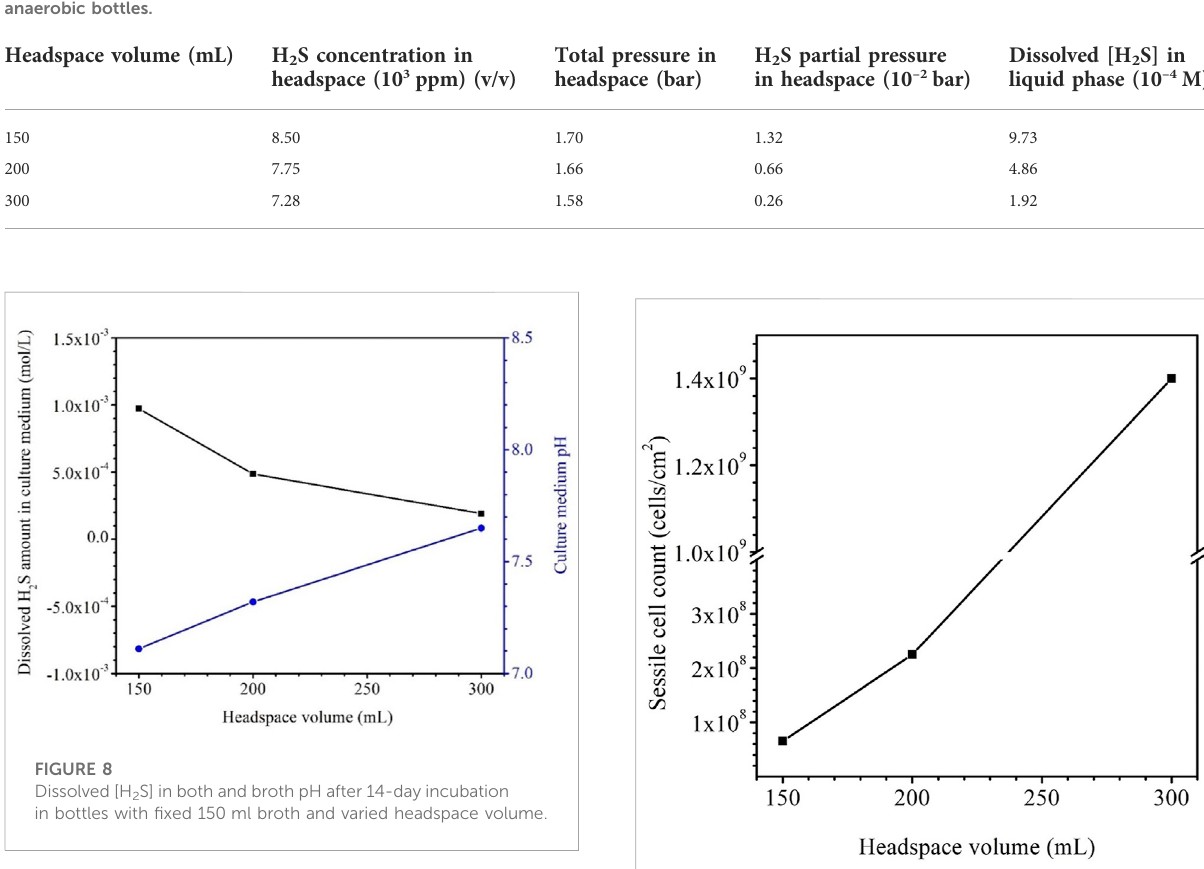
FIGURE 9 Sessile cell counts on dogbone coupons after